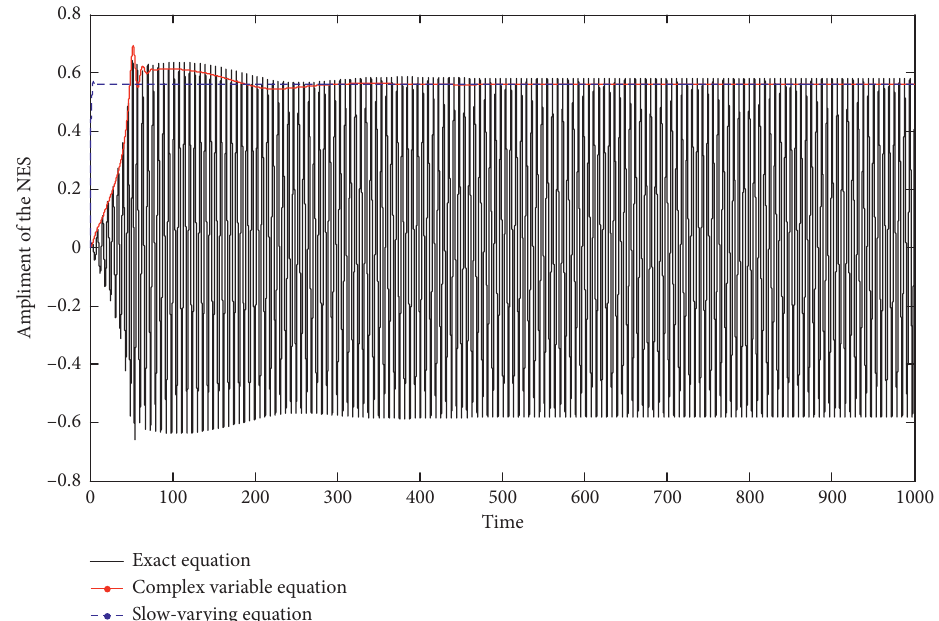
Figure 18: Time-history curves of nonlinear energy sink. The dashed line refers to the steady-state response of the slow-varying equation ( f � 0 .